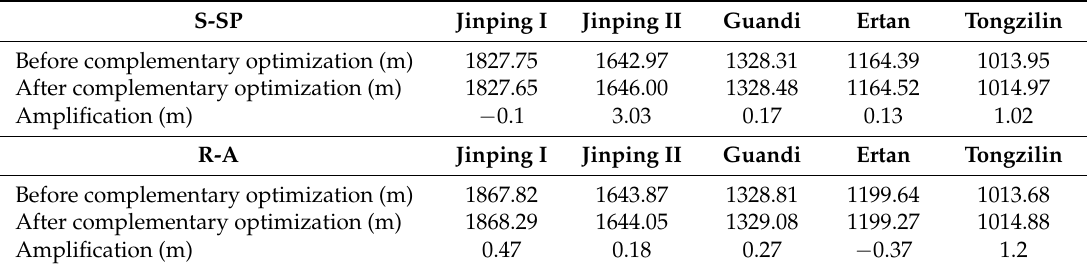
Table 4. The range of variation in final water level at each hydropower station. S-SP Jinping I Jinping II Guandi Ertan Tongzilin